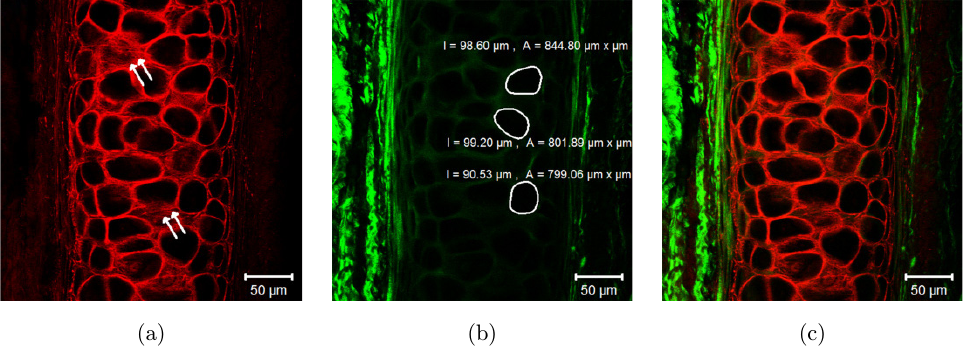
Fig. 1. Representative NLOM images of elastic cartilage in the rabbit external ear. (a) TPEF (red, 430 to 697 nm), (b) SHG (green, 398 to 409 nm), and (c) TPEF/SHG merged obtained by overlaying two channels. It clearly shows the elastic ¯bers (white arrows) and chondrocytes (white round-enclosed regions). The excited wavelength (cid:2) ex ¼ 810 nm. Scale bar ¼ 50 (cid:1) m.